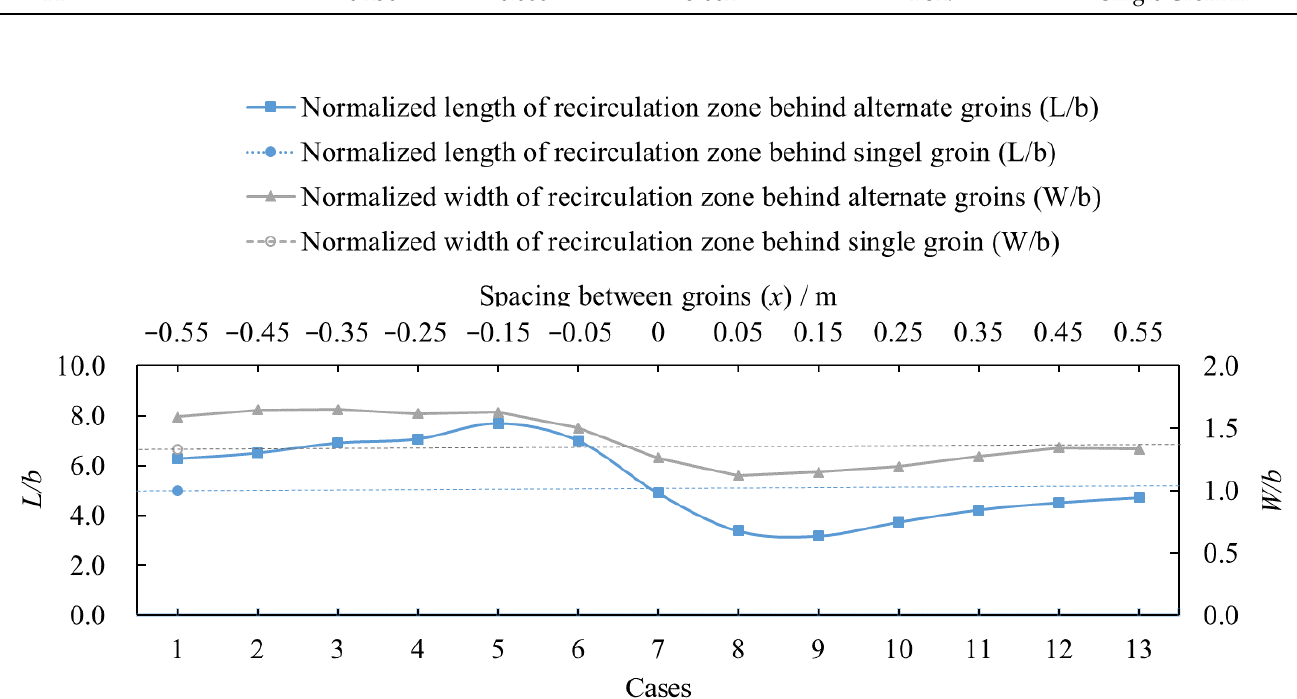
Figure 7. Normalized length L/b (left y -axis) and width W/b (right y -axis) of the recirculation zone behind a fixed Groin A as a function of the spacing (Top x -axis) between alternate groins on either side of river bank. The blue and gray circles are the normalized length of the recirculation zone for a single groin.